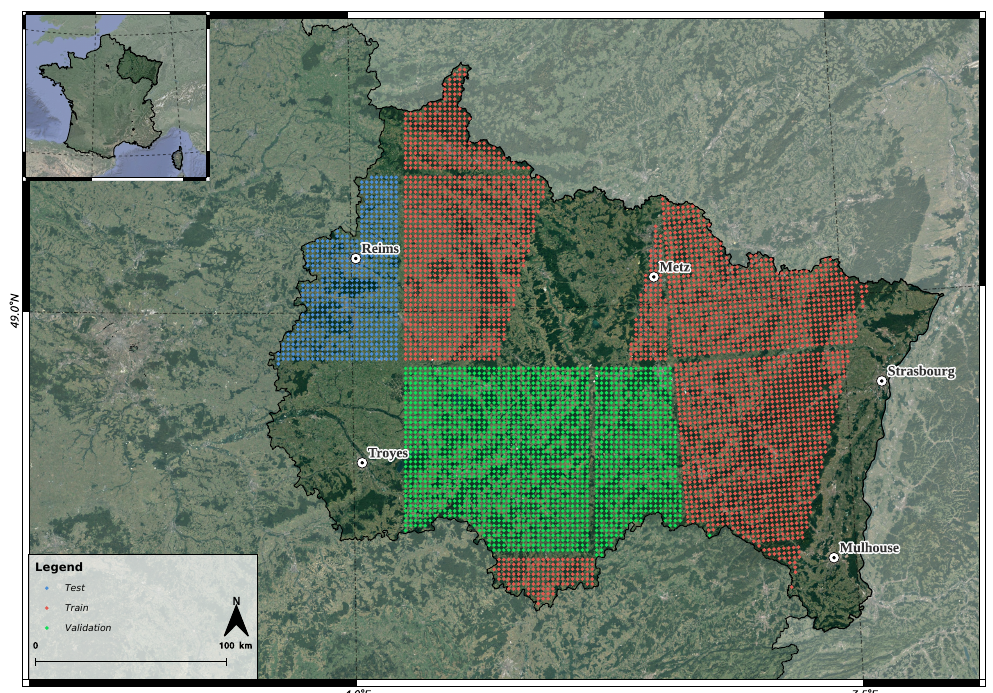
Figure 4. Train, validation and test sets for the selected multitemporal and multimodal patches.